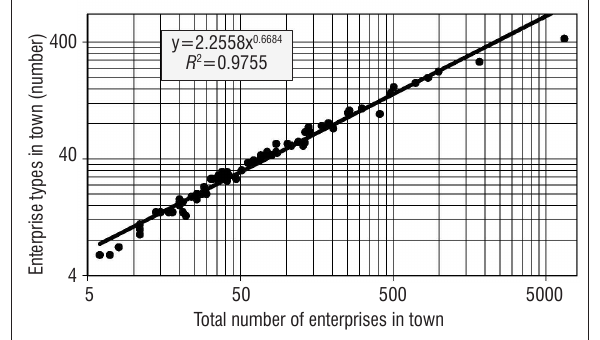
Figure 1: The relationship between the number of enterprise types (i.e. the enterprise richness) and the total number of enterprises in Free State towns and villages in 2012/2013.